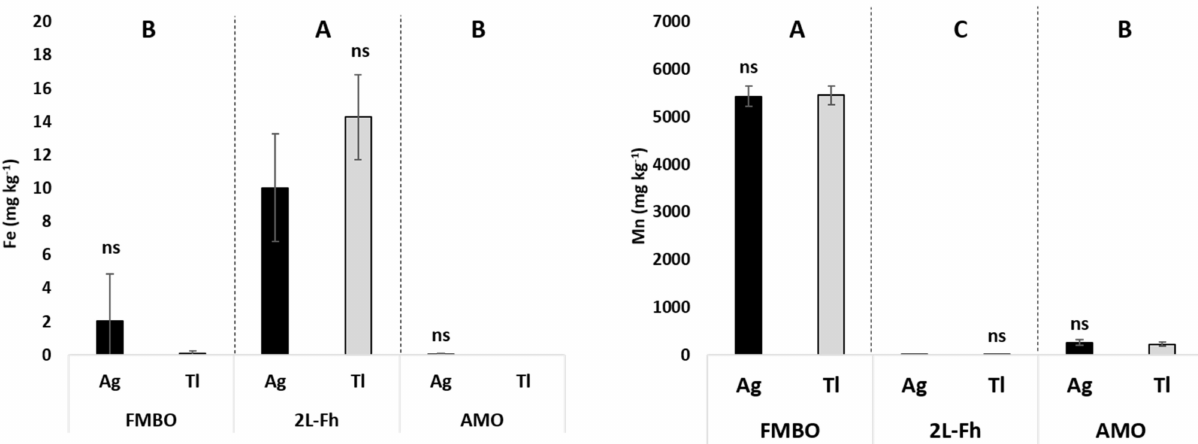
Figure 6. Dissolved Iron ( left ) and manganese ( right ) concentration (mg kg − 1 ) after three days of interaction of solutions of NO 3 Ag and NO 3 Tl with nano-amorphous metal oxides (FMBO, 2L-Fh, AMO). For each series different lowercase letters denote significant differences among the contaminants with respect to one nanomaterial, and uppercase denotes significant differences among nanomaterials according to Tukey HSD Test ( p < 0.05). ns: no significant